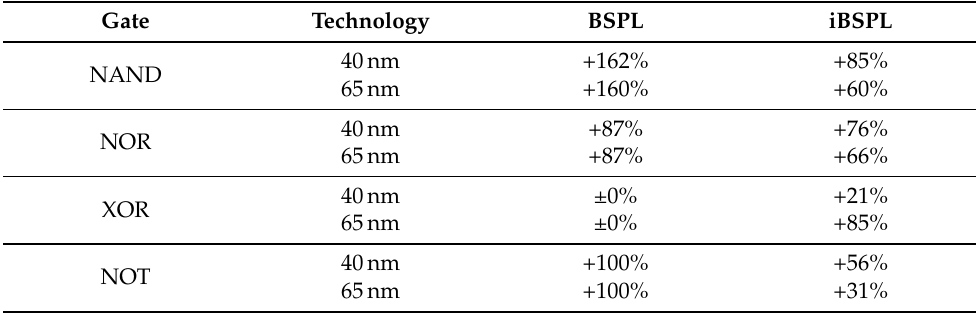
Table 4. Area overhead (transistor-only) of BSPL and iBSPL logic gates compared to regular CMOS standard cells.